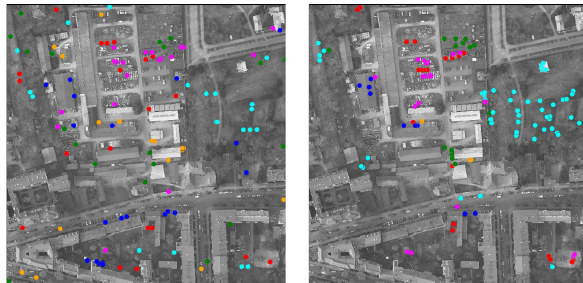
Figure 11. Click distribution on an image from Potsdam in automatic (left) and manual (right) evaluations. The colors represent the different classes.